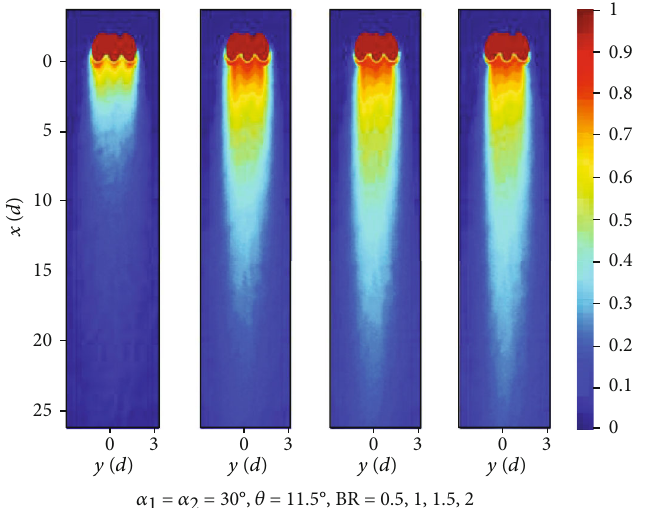
Figure 8: Film cooling e ff ectiveness distributions downstream of the branched holes, α